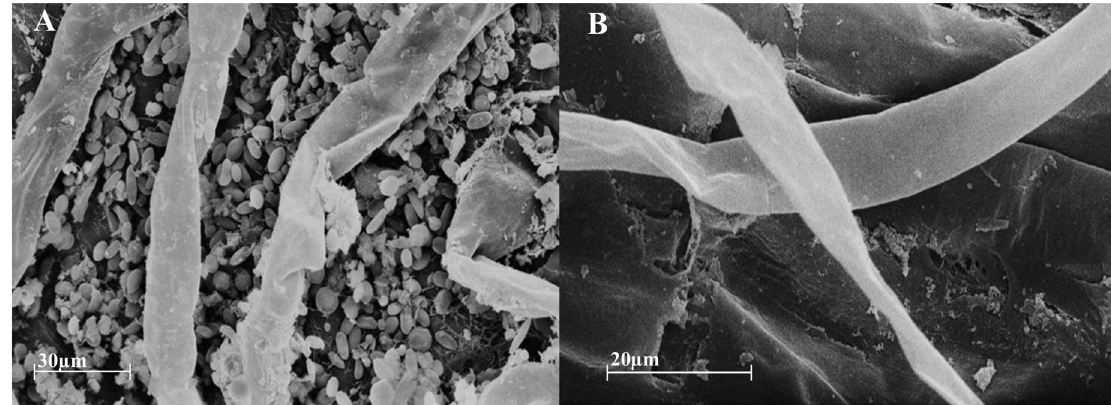
Figure 1. Scanning electron microscopy images of inoculated and non-inoculated corn roots. Scanning electron microscopy images showing the colonization of corn roots by the plant-beneficial rhizobacterium Azospirillum brasilense . (A) Inoculated corn roots and (B) non-inoculated corn roots.